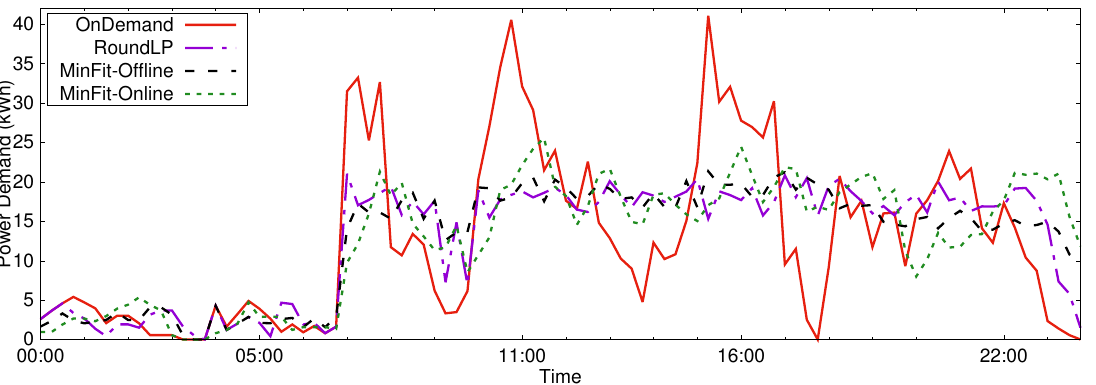
Figure 4. Performance of PDM scheduling algorithms in a larger scenario. Total demand over time is plotted for each